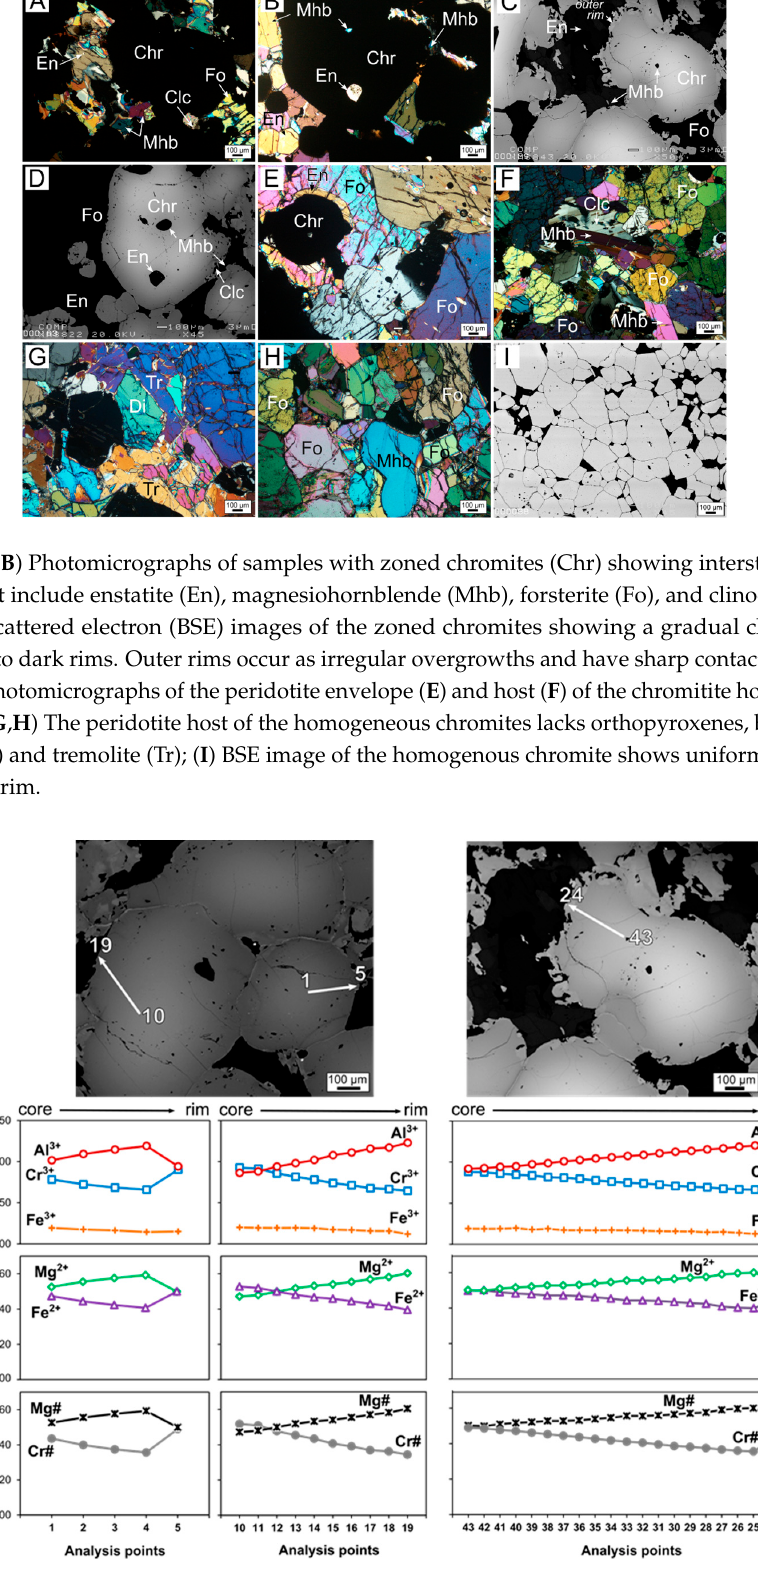
Figure 3. Line analyses of zoned chromite grains showing a decrease of Cr and Fe coupled with Al and Mg enrichment from core to rim (a.p.f.u., (atoms per formula unit) for O = 4). Typical outer rims are Cr-rich and Al-depleted (shown as analysis point no. 24).